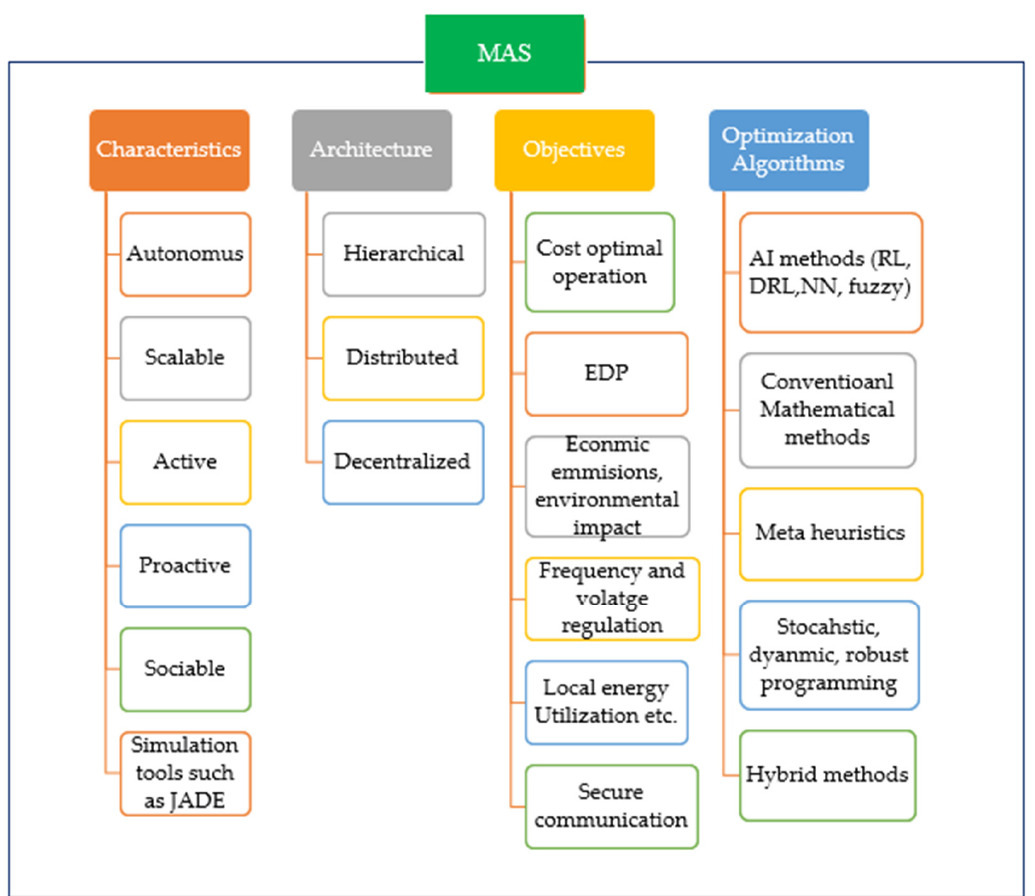
Figure 8. Constituents of MAS for achieving energy trilemma aspects in MGs-EMS. Table 3. MAS control methods for EMS in MGs and perspective of energy trilemma .